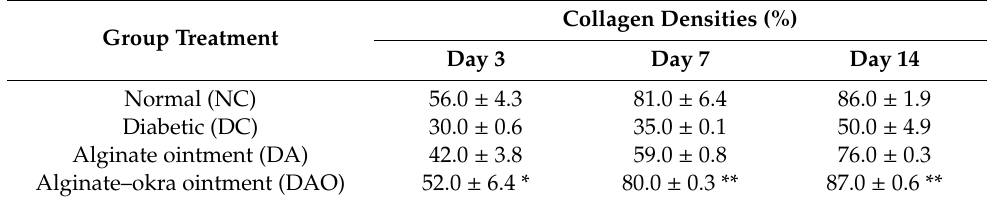
Table 8. Counts considering the mean and standard deviation of collagen